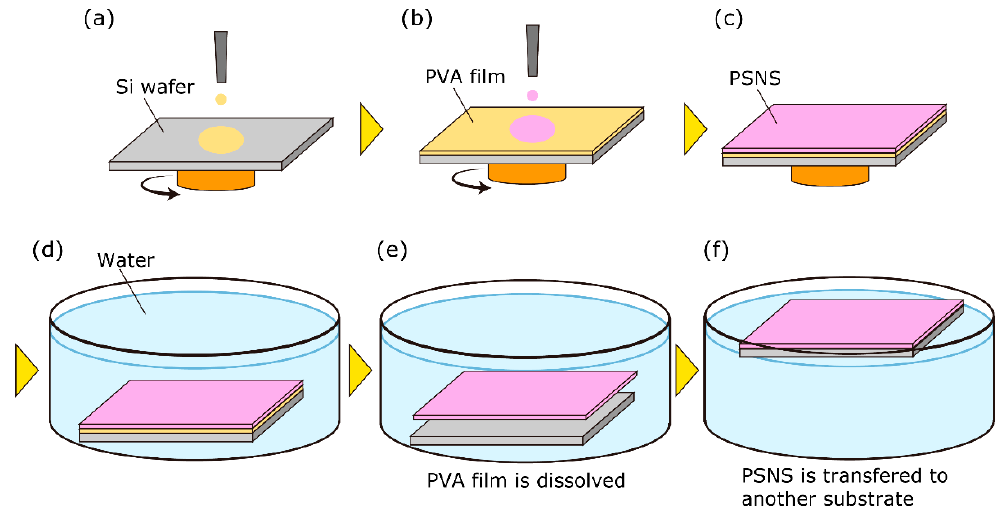
Figure 1. Schematic of PSNS fabrication process based on a sacrificial layer process using a spin-coating method. ( a ) PVA solution is spin-coated on Si wafer. ( b ) PSNS is spin-coated on the PVA film. ( c ) fabricated PSNS and PVA film ( d ) Obtaied film is immersed in water. ( e ) PVA film is dissolved and free standing PSNS is obtained. ( f ) PSNS is transferred to another substrate.